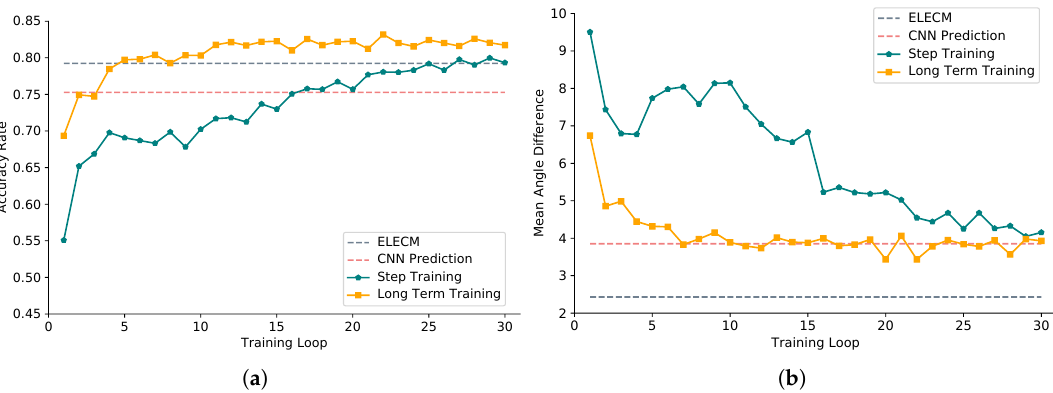
Figure 12. Prediction performance of Eigenvectors with the Largest Eigenvalue of Covariance Matrix (ELECM), Convolutional Neural Network (CNN), Agent trained through step training and Agent trained through long term training. ( a ) accuracy rate of four models at different training loops; ( b ) mean angle difference ( ◦ ) of four models at different training